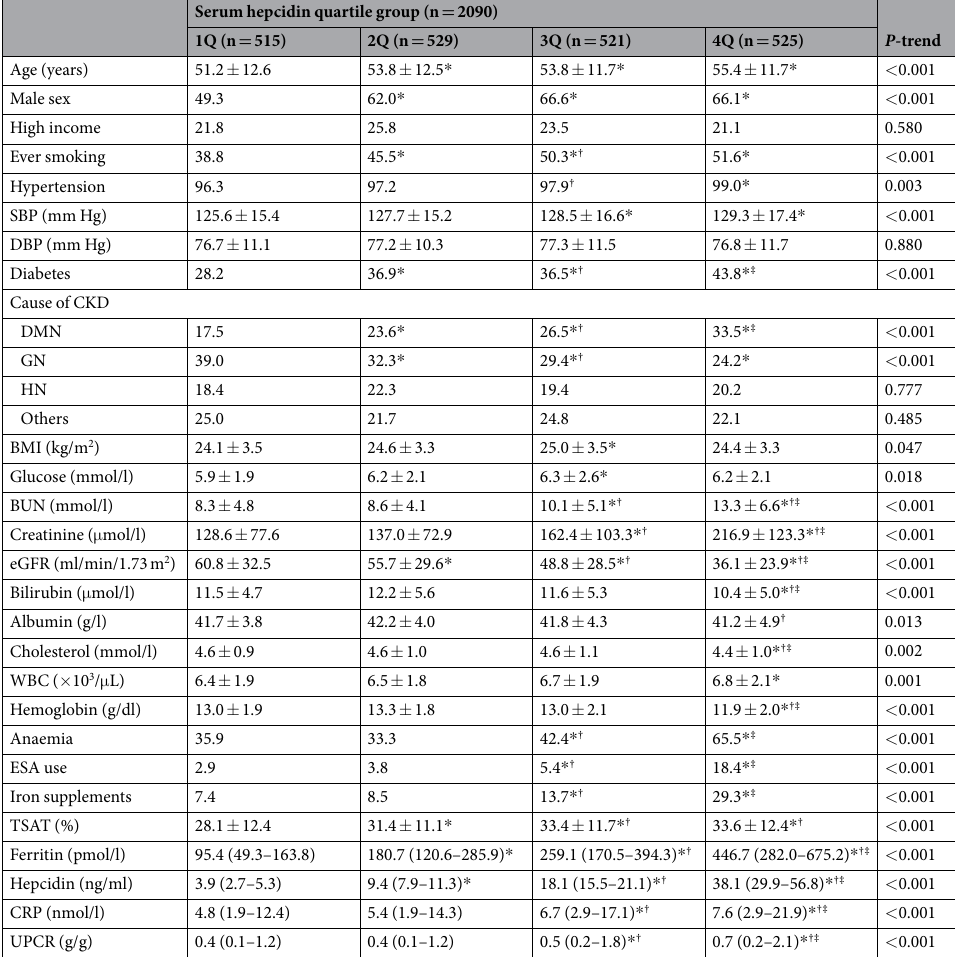
Table 1. Baseline characteristics of the hepcidin quartile group. Q, quartile; SBP, systolic blood pressure; DBP, diastolic blood pressure; CKD, chronic kidney disease; DMN, diabetic nephropathy; GN, glomerulonephritis; HN, hypertensive nephropathy; BMI, body mass index; BUN, blood urea nitrogen; eGFR, estimated glomerular filtration rate; WBC, white blood cells; ESA, erythropoiesis stimulating agents; TSAT, transferrin saturation; CRP, C-reactive protein; UPCR, urine protein-to-creatinine ratio. Values are expressed as mean ± standard deviation for normally distributed continuous variables, median (interquartile range) for non-normally distributed continuous variables, and percentage for categorical variables. P -trend was analyzed by linear-term of one-way ANOVA for normally distributed continuous variables, Jonckheere-Terpstra test for non-normally distributed continuous variables, and a linear-by-linear association for categorical variables. * ,† , and ‡ meant P < 0.05 when compared to 1Q, 2Q, and 3Q of serum hepcidin, respectively, by using Bonferroni post-hoc analysis of one-way ANOVA for normally distributed continuous variables, Mann-Whitney U test for non- normally distributed continuous variables w, and chi-square test for categorical